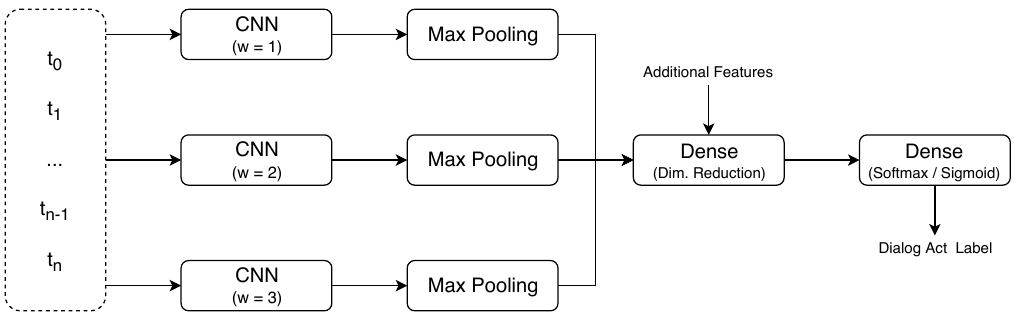
Figure 1. The generic architecture of the network used in our experiments. t i corresponds to the embedding representation of the i th token. w corresponds to the context window size of the CNN. The number of parallel CNNs and the respective window sizes vary between experiments. Those shown in the figure correspond to the ones used by Liu et al. [6] in their experiments, which we adopt for the word-level